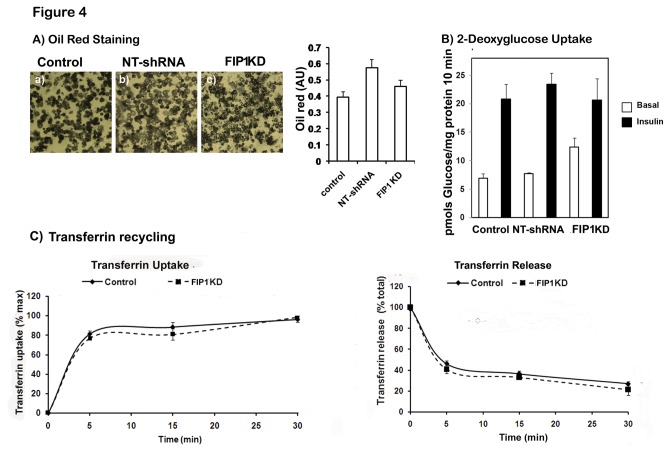
Knock down of FIP1 does not alter adipogenesis, insulin-stimulated Glut4 translocation or transferrin receptor recycling.Control 3T3L1 cells (non-infected), and 3T3L1 cell lines stably expressing a non-targeting shRNA or shRNAs for FIP1 were cultured and differentiated to adipocytes and used on day 10 after differentiation. A) Cells were fixed and stained with oil red and visualized under a light microscope. Images were taken in a Leica microscope. Representative images are shown from at least three independent experiments. Oil red stain was extracted in isopropanol and the absorbance quantified at 500 nm. B) Cells were serum starved in DMEM for 3 hours and either left untreated or treated with insulin (100 nM) for 30 minutes. 3H-2-deoxyglucose uptake was then measured for 10 minutes as indicated in the material and methods section. 3H -2-deoxyglucose uptake at 1 mM final concentration for 10 minutes is within the linear range in these cells (not shown) C) Transferrin recycling. Transferrin uptake: control and FIP1 Knock down 3T3L1 cells were incubated with Alexa-488 conjugated transferrin as indicated in the methods section. At different time points cells were washed and the intracellular fluorescence determined by flow cytometry. Transferrin release: Cells were first loaded with Alexa-488 transferrin for 45 minutes at 37°C and then washed at different time points as indicated. Cells were collected and intracellular fluorescence quantitated by flow cytometry as described in the methods section. Results show mean ± SEM of 2 independent experiments quantified in triplicate.